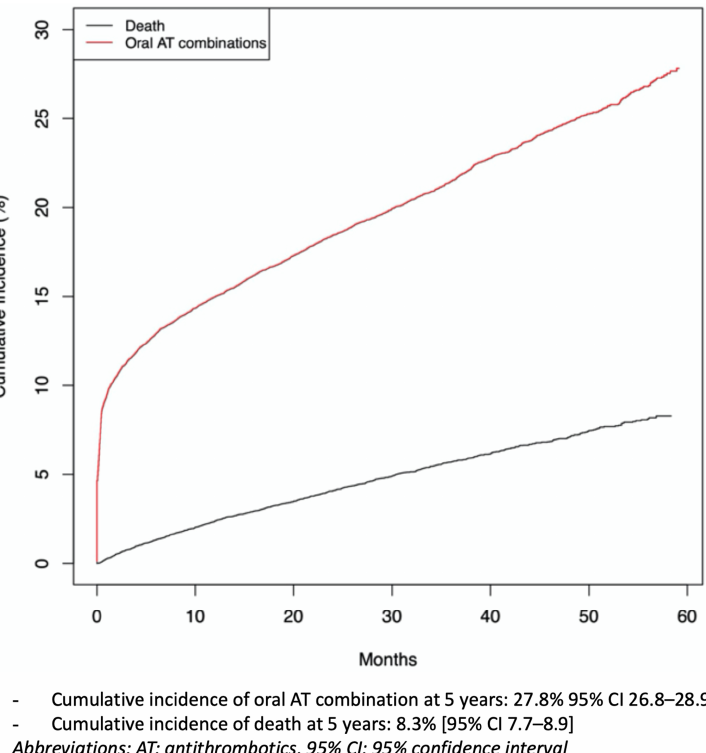
Figure 2. Cumulative incidence curves of oral antithrombotic (AT) combination and death for the whole cohort ( n = 22,220), over the 5-year study. 3.4. Appropriateness of Oral AT Combinations When examining the appropriateness of all oral AT combinations ( n = 5945), 370 (6%) were contraindicated and, among the other oral AT combinations, 3446 (58%) had no rec- ommended indication for use: 51% for dual antiplatelet therapies, 92% for dual therapies and 69% for triple therapies (Figure 3). In total, 64% of oral AT combinations were inap- propriate, in terms of indication, according to guidelines (Figure 3). Sensitivity analyses are presented in Supplemental Table S7: the longer the cut-off used to describe an oral AT